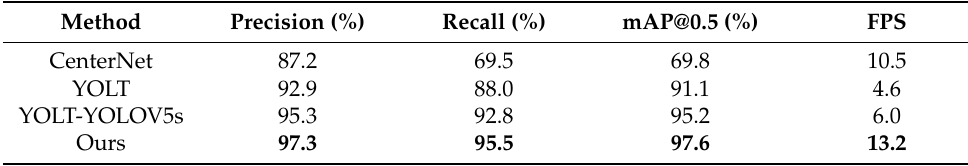
Table 2. Experimental results of various algorithms on the test set.